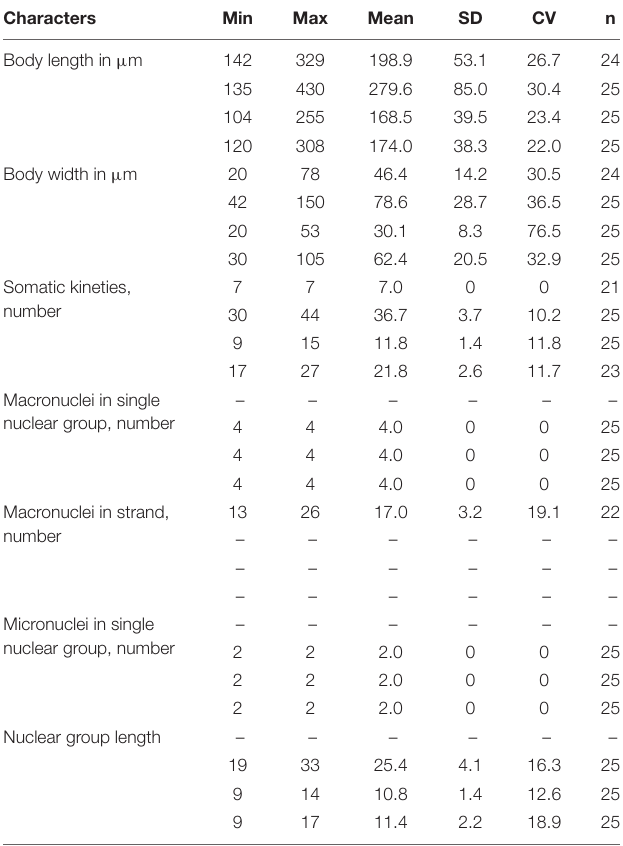
TABLE 3 | Morphometric data for Paratrachelocerca typica gen. nov., spec. nov. (first line), Trachelolophos monocaryon (Dragesco, 1965) comb. nov. (second line), Tracheloraphis katzae spec. nov. (third line), and Tracheloraphis colubis (fourth